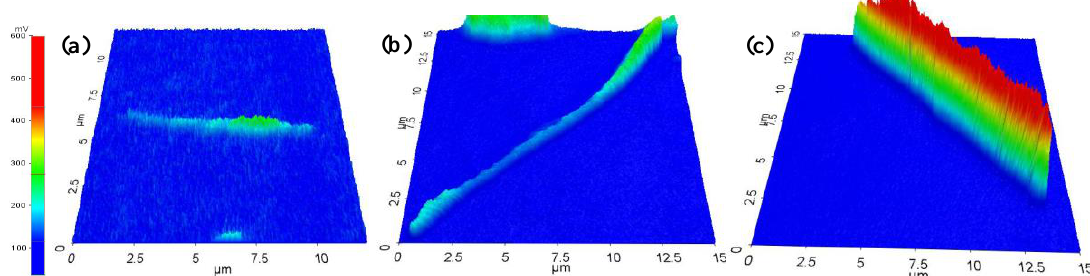
Figure 3. 3-D photoluminescence (PL) images of ( a ) P3MT/pDNA-tDNA (10 – 10 pairs), ( b ) P3MT/pDNA-tDNA (20 – 20 pairs) and ( c ) P3MT/pDNA-tDNA (30 – 30 pairs) single NWs. The color scale bar on the left-hand side represents the photon counts.